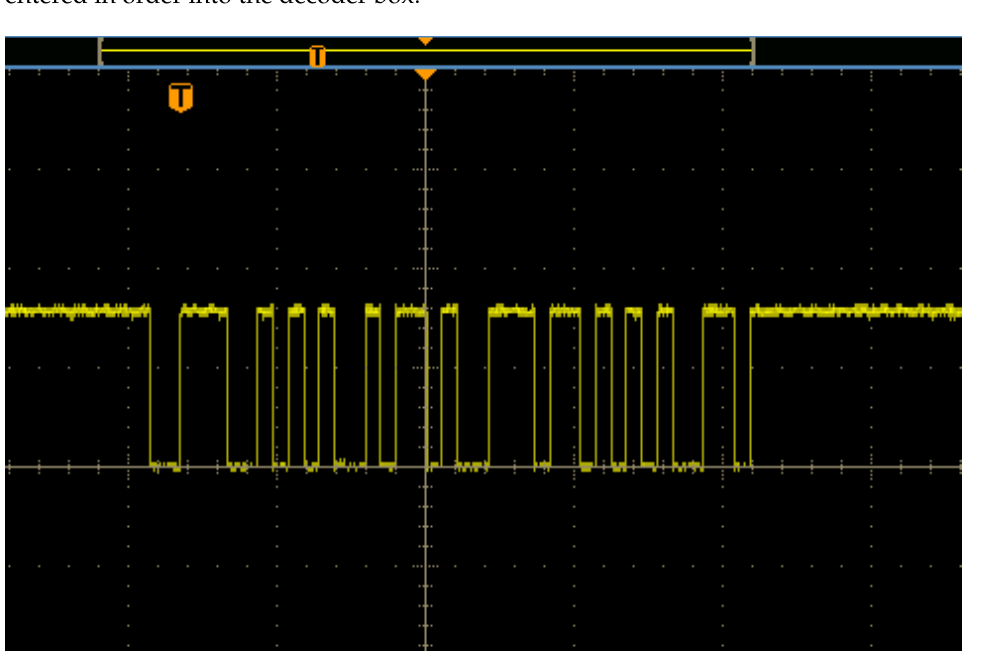
Figure 2. UART Puzzle which spells out